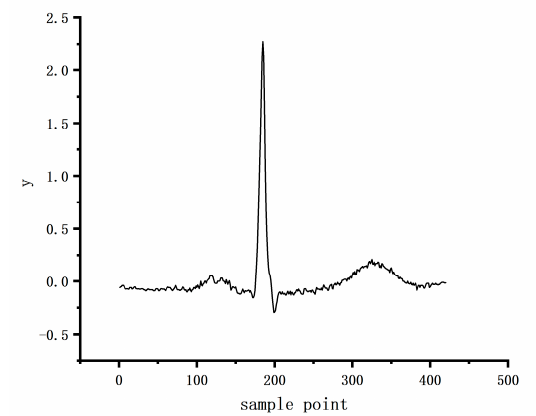
Figure 5. Schematic diagram of a single heartbeat.